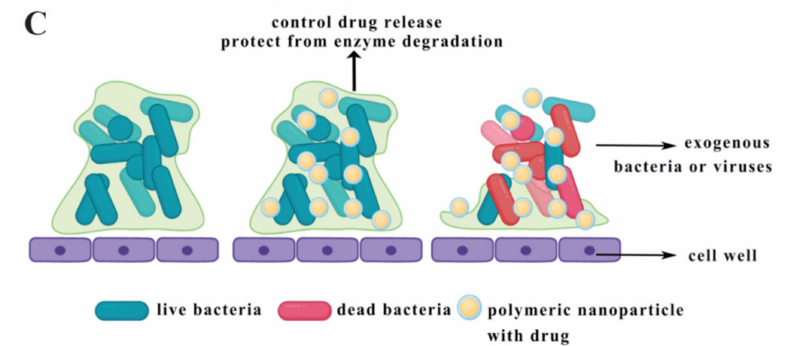
Figure 5. ( A ) Schematic model of polymeric nanoparticles adapted from [115]. ( B ) PLGA nanoparti- cles with peptides as liver-target drug delivery system adapted from [43]. ( C ) Antibacterial process of polymeric nanoparticles